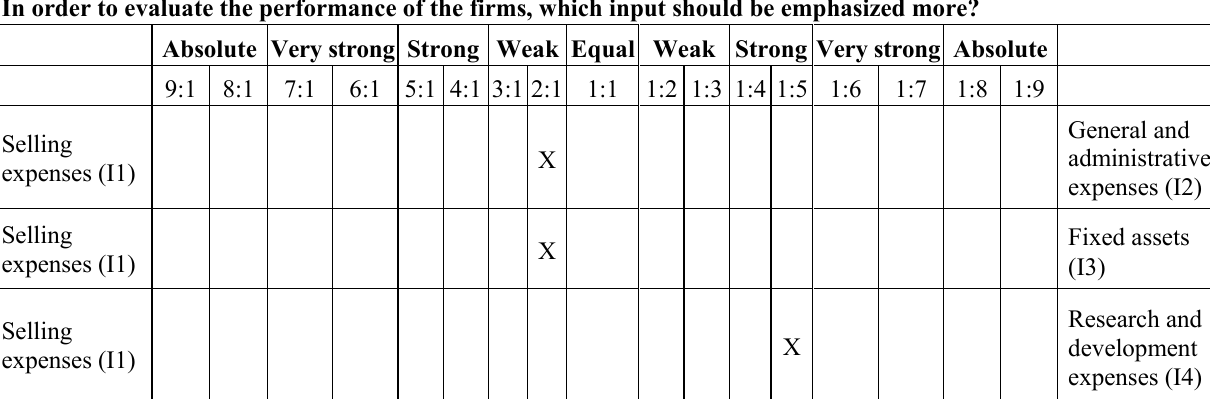
Table 7. Pairwise comparison of factors by Expert